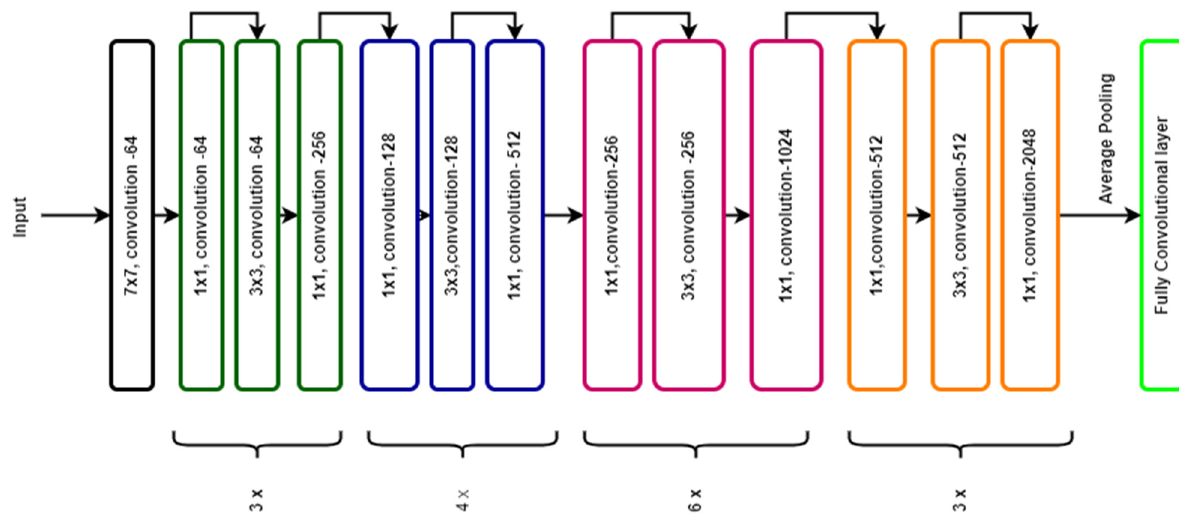
Figure 4. Block diagram of the ResNet-50 architecture.